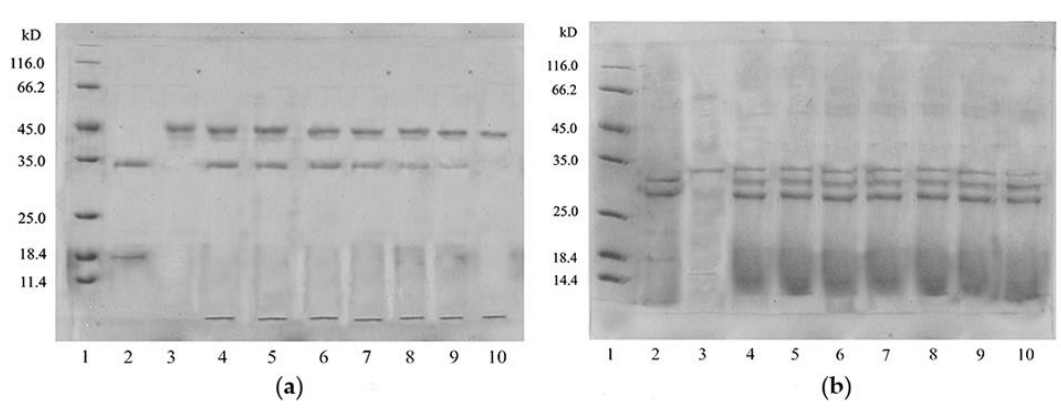
Figure 10. ( a ) Simulated gastric fluid (SGF) digestion profiles of the native lectin from the Zihua snap bean. In the SDS-PAGE analysis, lane 1 was the molecular weight marker, lane 2 was the native lectin, lane 3 was the pepsine, and lanes 4 to 10 were the SGF digestion pattern of the native lectin at 0 min, 2 min, 5 min, 10 min, 20 min, 30 min, and 60 min. ( b ) Simulated intestinal fluid (SIF) digestion profiles of the native lectin from the Zihua snap bean. In the SDS-PAGE analysis, lane 1 was the molecular weight marker, lane 2 was the native lectin, lane 3 was the tryptic, and lanes 4 to 10 were the tryptic digestion pattern of the native lectin at 0 min, 10 min, 20 min, 30 min, 40 min, 60 min, and 90 min.